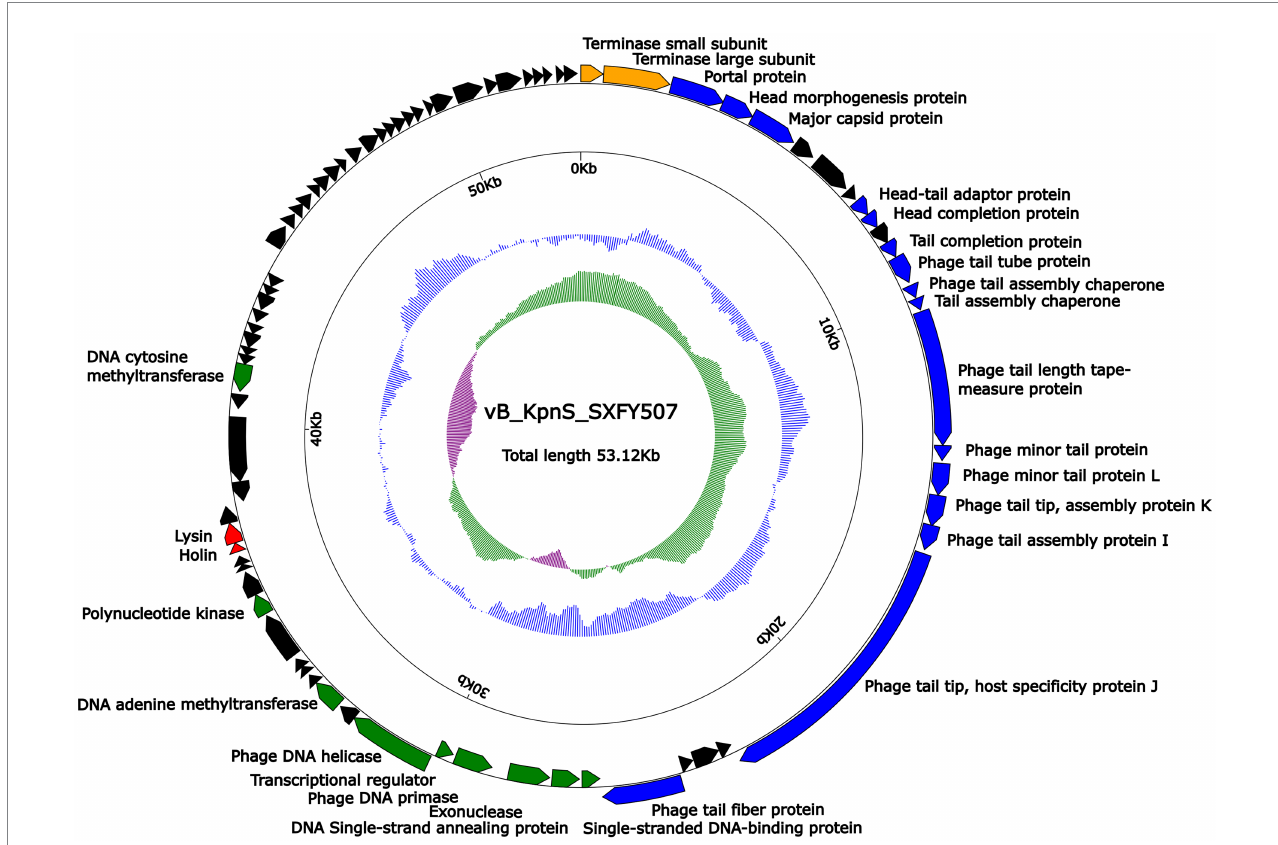
FIGURE 3 Schematic maps of phage vB_KpnS_SXFY507 genome. Genes are denoted by arrows and colored based on function classification (blue: morphogenesis; green: replication and regulation; orange: DNA packing protein; red: lysis; and black: hypothetical protein). The innermost circle presents GC-skew [(G − C)/ (G + C)], with a window size of 500 bp and a step size of 20 bp. The next-to-innermost circle presents GC content.